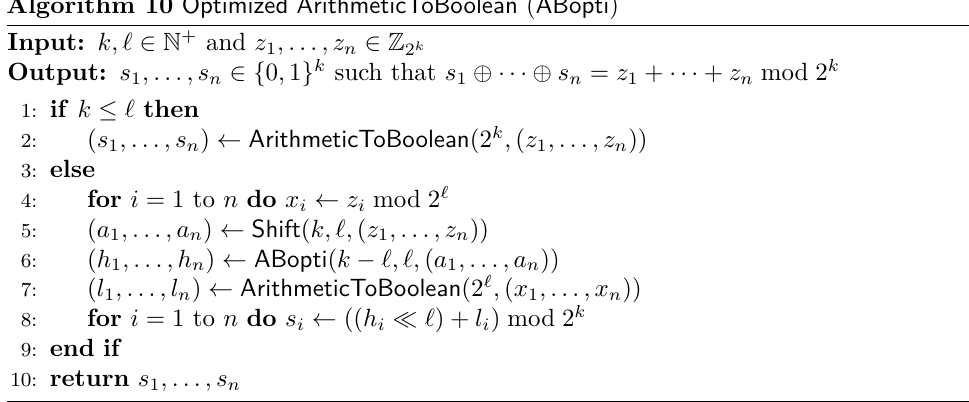
Algorithm 10 Optimized ArithmeticToBoolean ( ABopti